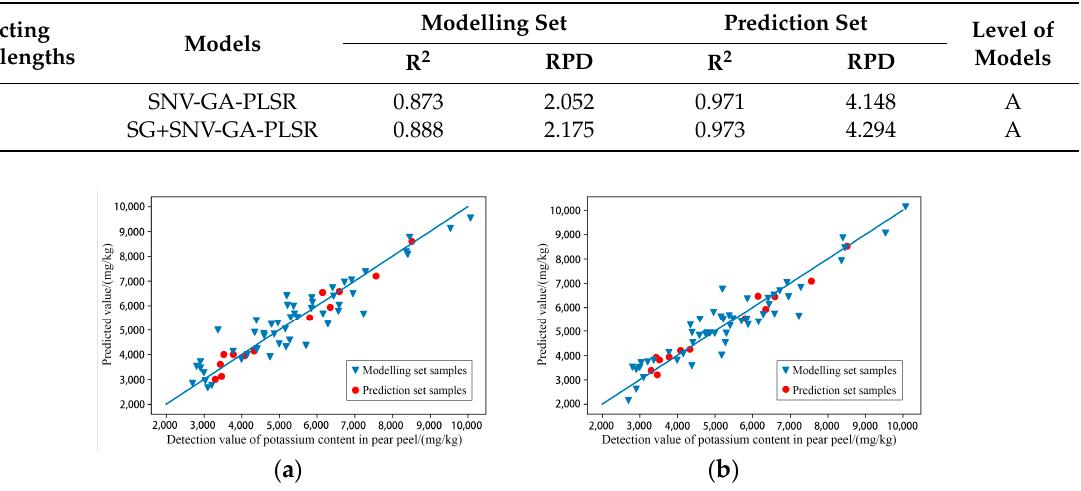
Table 9. Modelling prediction results of the content of potassium in pear peel based on the selected characteristic wavelengths.